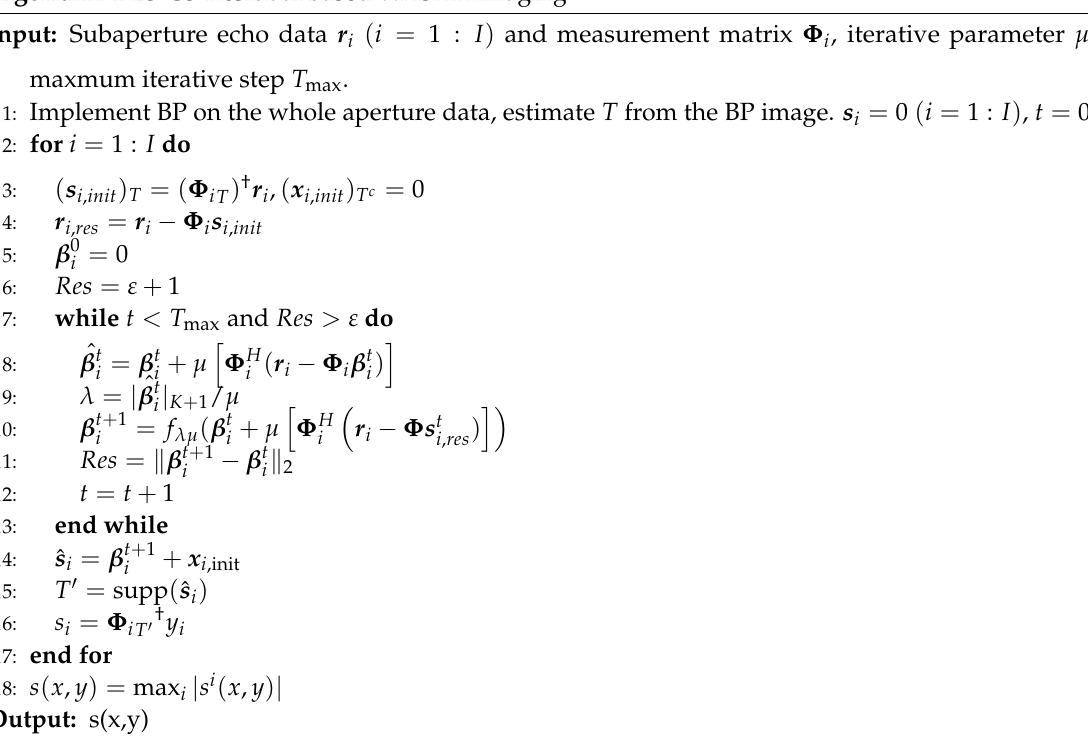
Algorithm 1 LS-CS-Residual based WASAR